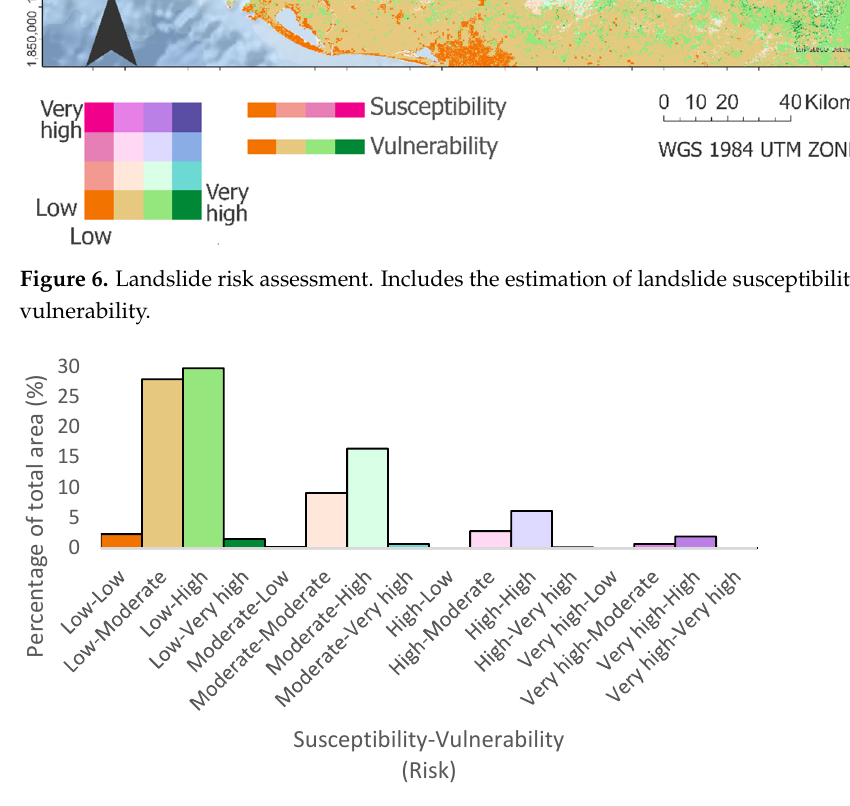
Figure 6. Landslide risk assessment. Includes the estimation of landslide susceptibility and landslide vulnerability.